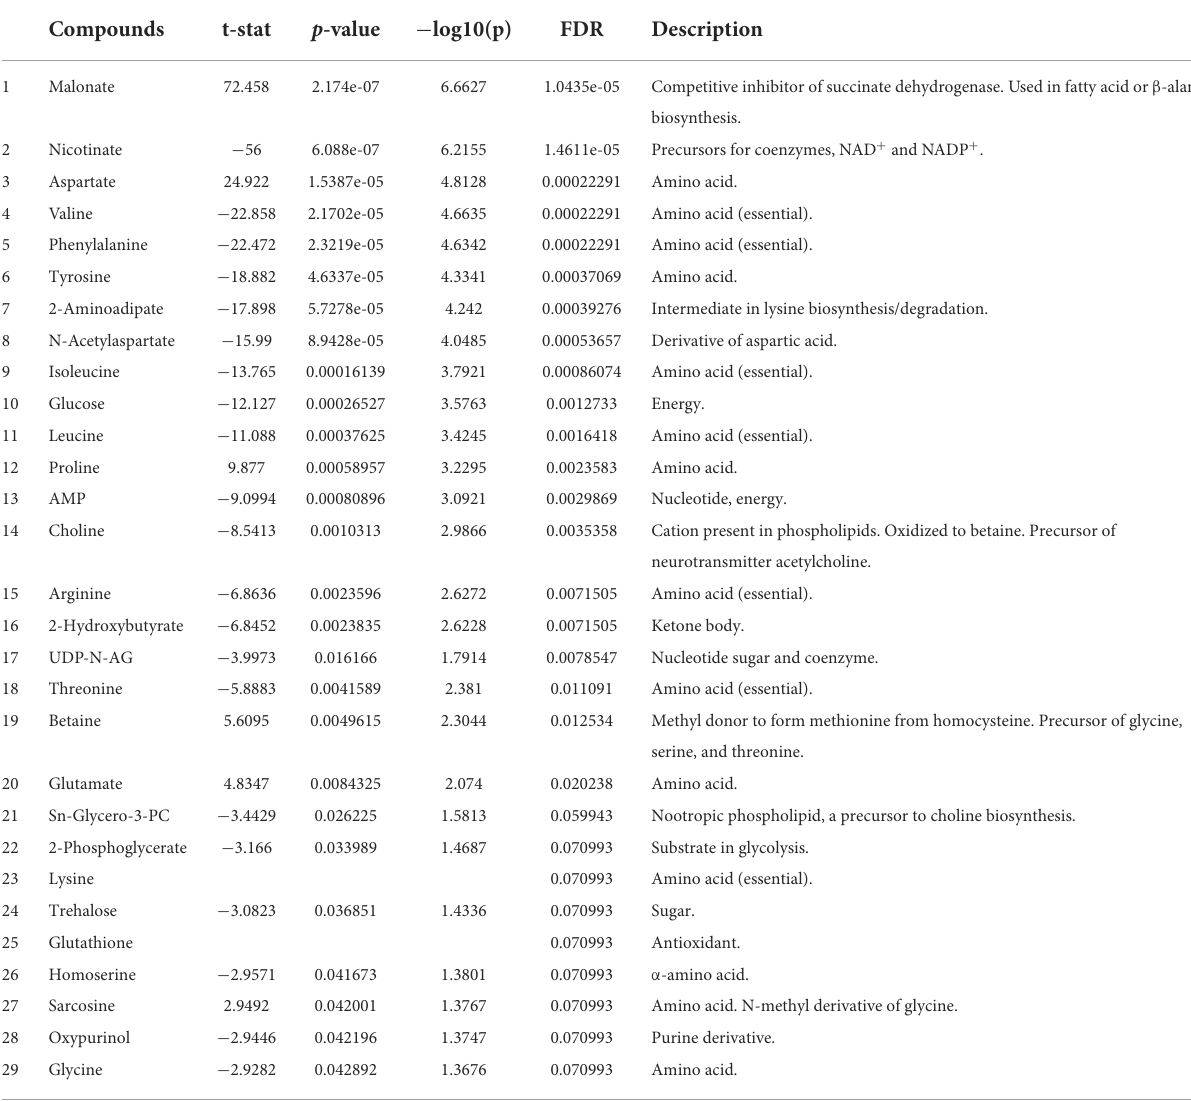
TABLE 2 Important features selected by t -tests for separation of W-OP50 and